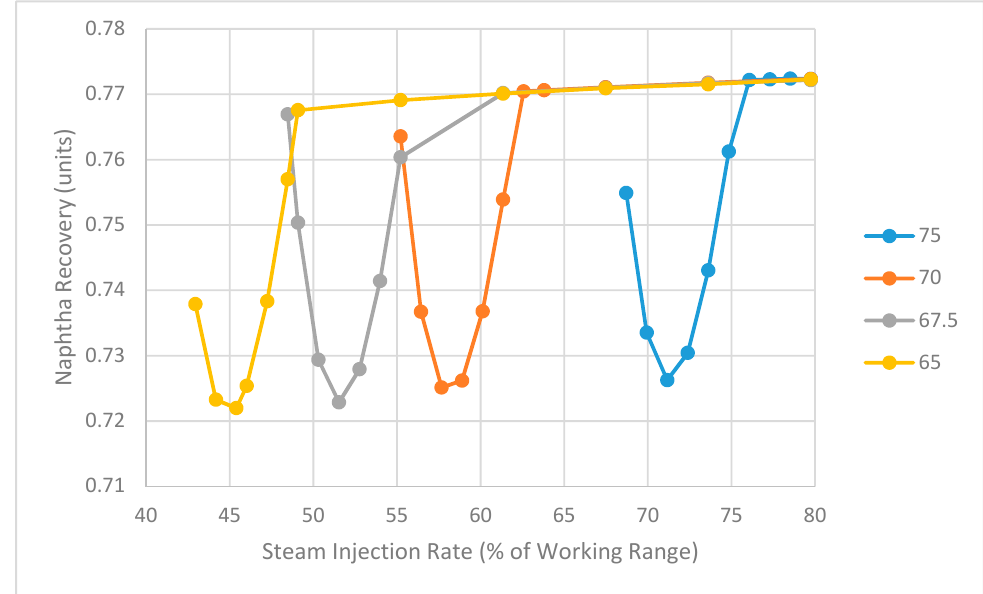
Figure 17. Impact of steam and cooling water flowrate on naphtha recovery as predicted by Aspen Plus model (4 different cooling water duties shown with units of MMBTU/h).